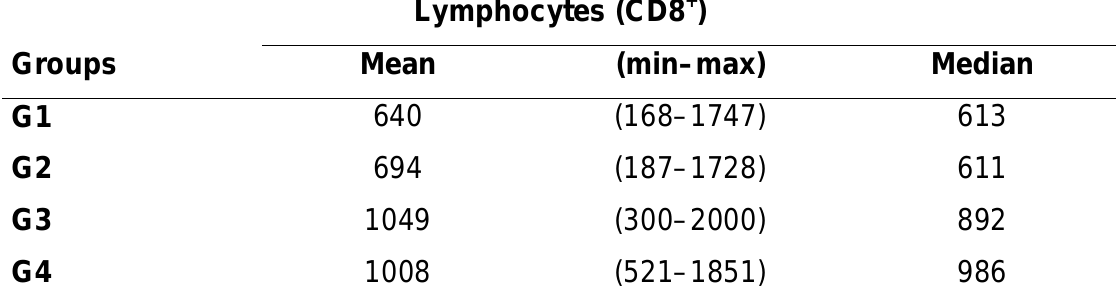
Table 2. Patient distribution according to CD8 + T lymphocyte counts/mm 3